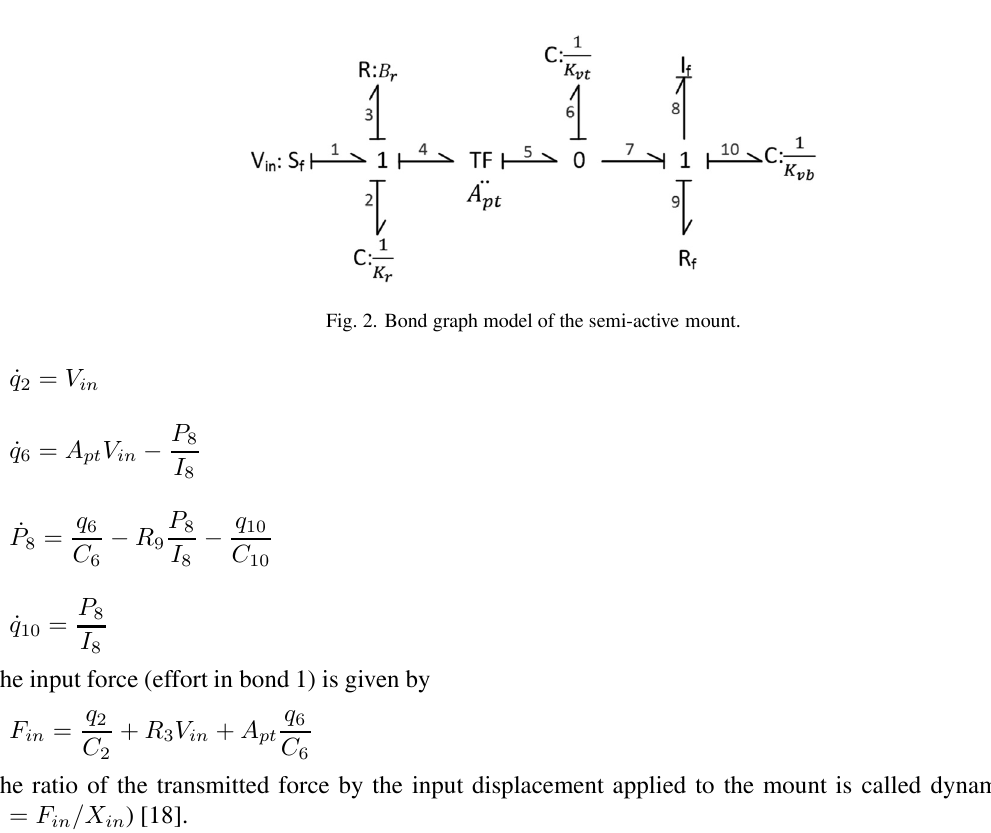
Fig. 1. Proposed semi-active hydraulic mount.